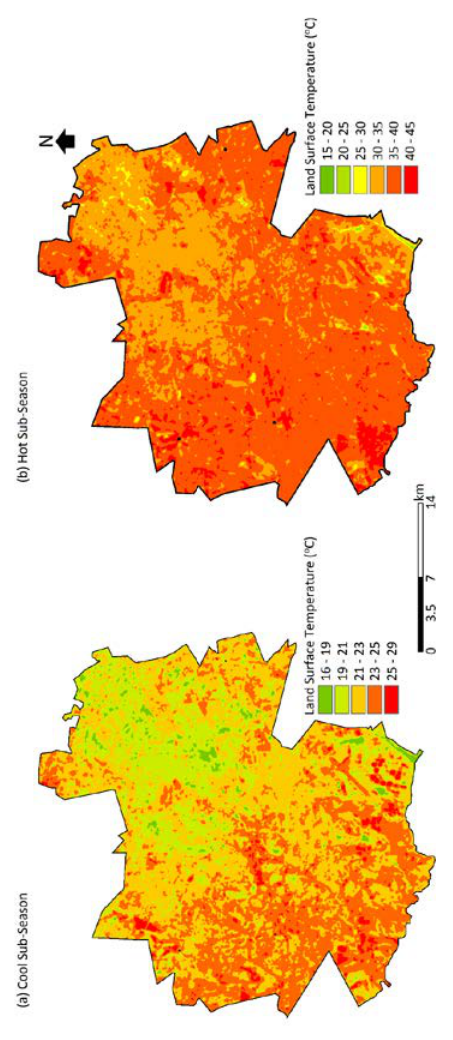
Figure 5: Relationship between LCZ and LST in Harare for the cool and hot